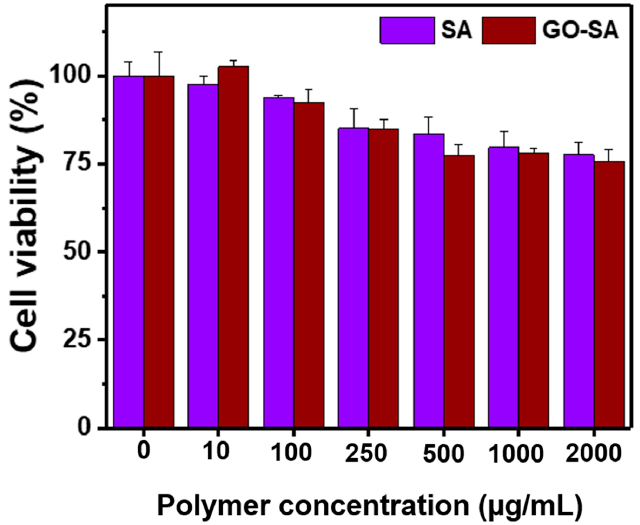
Figure 6. The in vitro cell viability of L929 mouse fibroblast cells exposed with different concentration of SA and GO-SA hydrogels. The error bars in the graph represent standard deviations (n = 4).